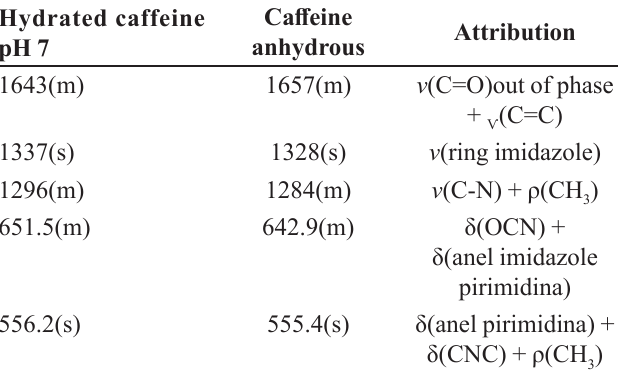
TABLE II - Raman spectrum and attributions for hydrated and